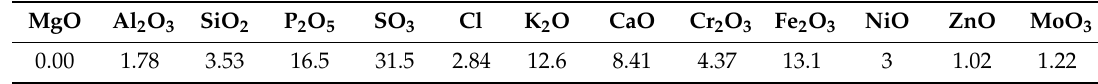
Table 2. Chemical composition of the SF